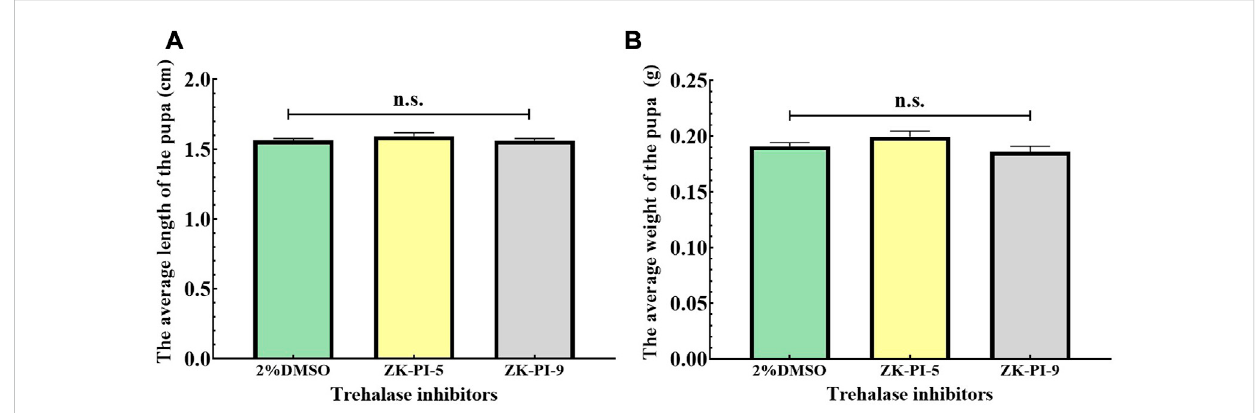
FIGURE 5 Pupal length (A) andweight (B) of S.frugiderda afterinjectionoftwotrehalaseinhibitors.Thebodylengthandweight of S.frugiderda inpupal stages were measured and recorded. Values are presented as the means ± SE. n.s.: not signi fi cant (independent-samples t -test).